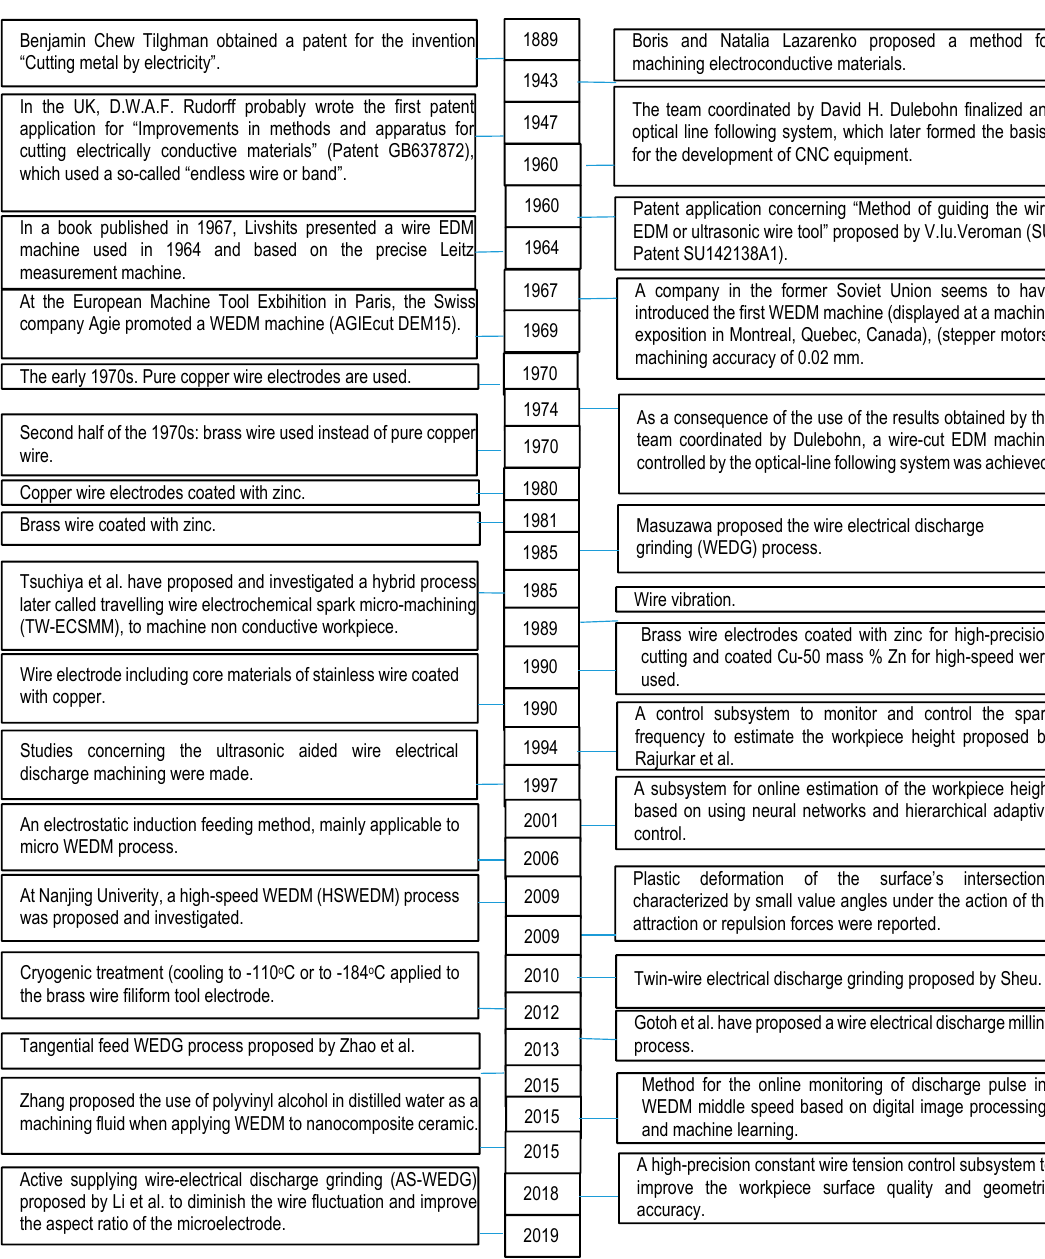
Figure 2. Evolution of knowledge about WEDM processes and equipment.